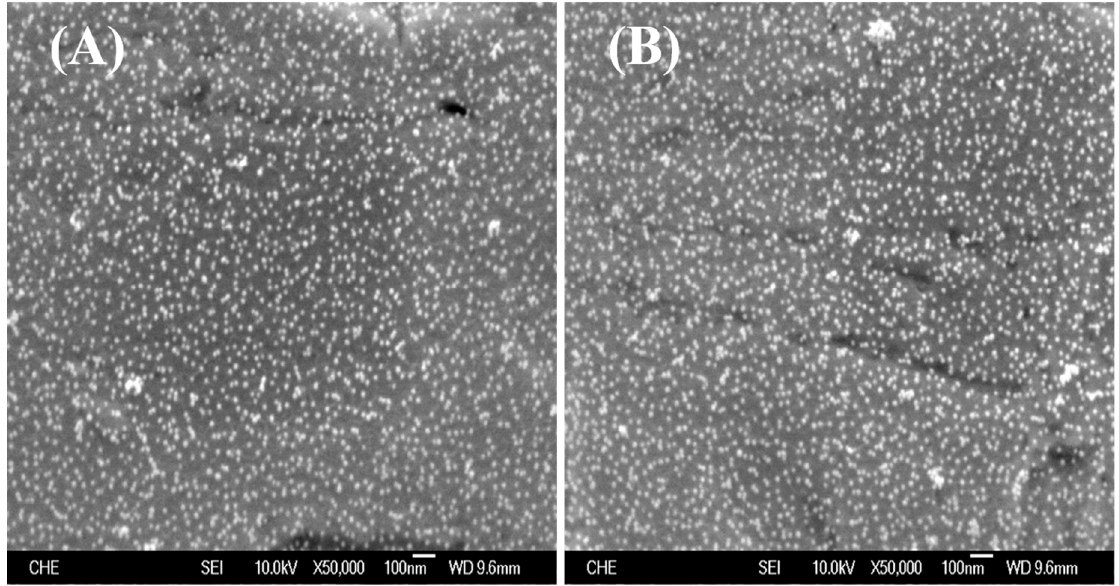
Figure 3. SEM topography images of PEDOT/PEDOT:PSS dual-layer film on the Pt electrode ( A ) before and ( B ) after multiple DPV measurements.